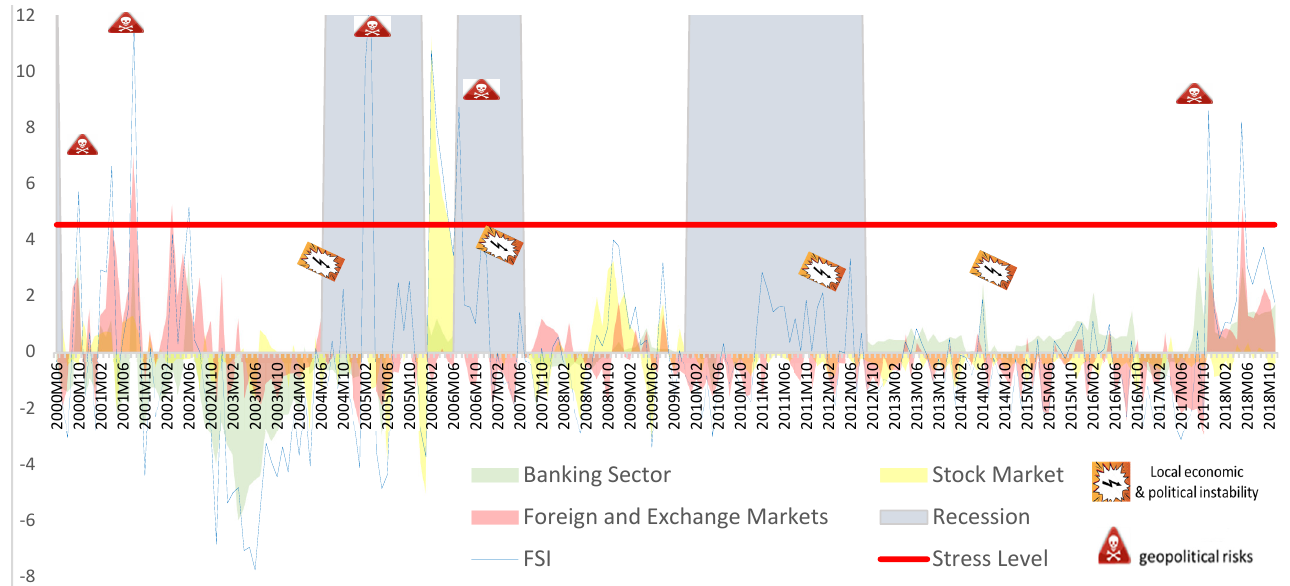
Figure 2. The recession periods, the FSI and the FSI’s sectors. Source: the author’s calculations and elaboration. Data are available with the